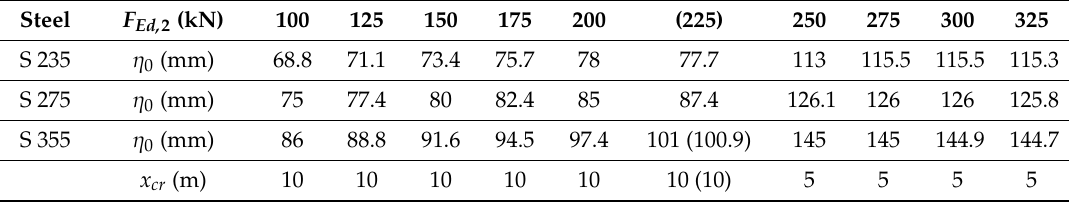
Table 6. Example 5: influence of the value of F Ed,2 and the steel grade. Values in brackets are from [24].